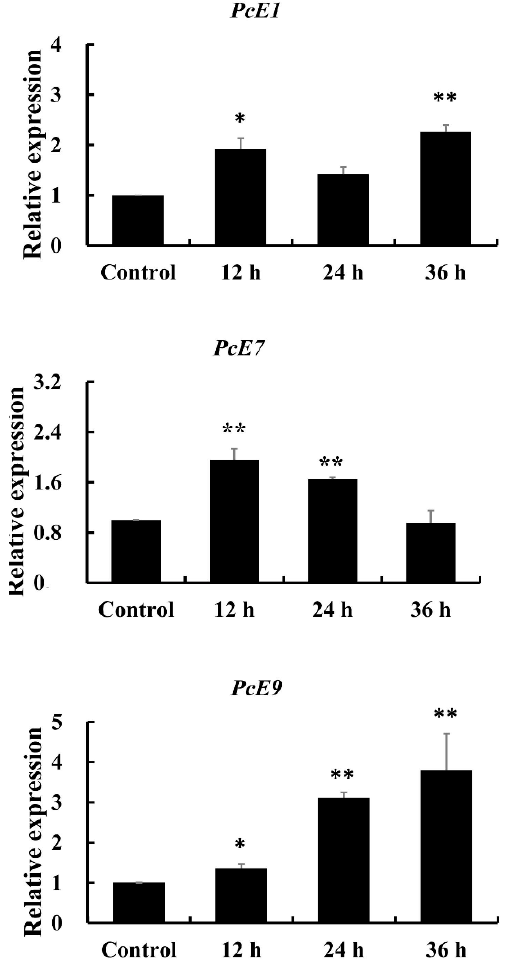
Figure 2. Expression patterns of PcE1 , PcE7 and PcE9 in response to fenpropathrin exposure. Relative expression levels were calculated based on the control, which was defined as a basal value of 1. The vertical bars indicated standard errors of the mean ( n = 3). The asterisk on the vertical bars indicate significant differences in the mRNA level of between control and treatment (Student’s t -test, * p < 0.05 and ** p < 0.01).